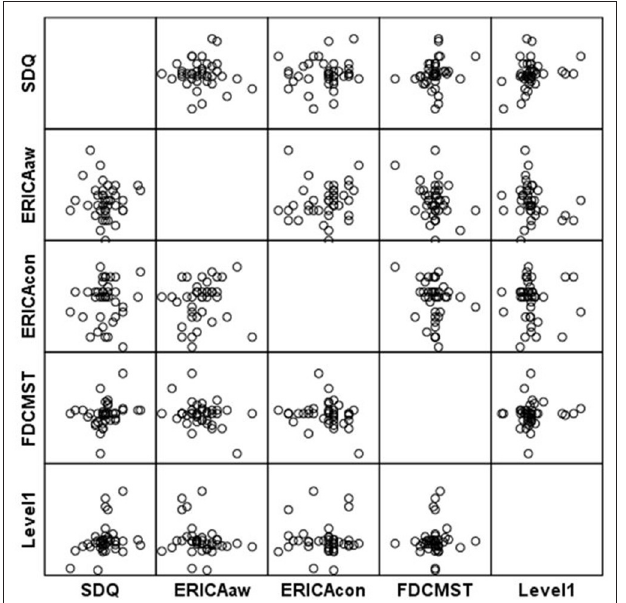
FIGURE 1 | Scatterplot matrix for Level 1 scores.